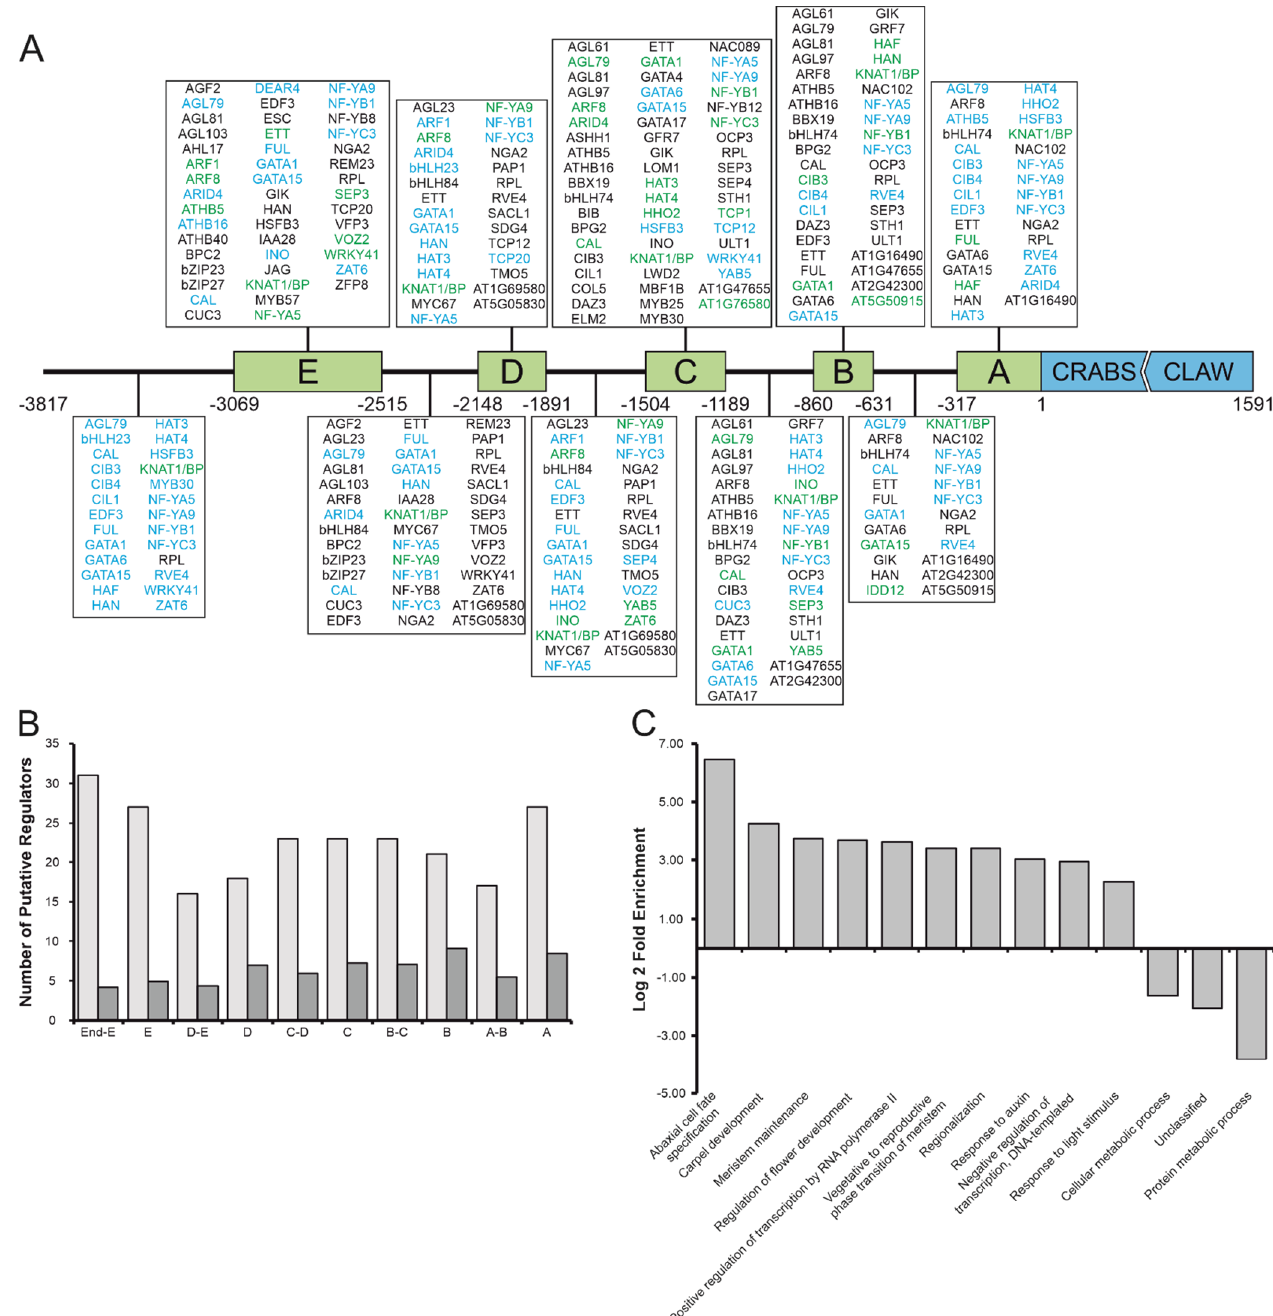
Figure 2. Analysis of transcription factors binding to the CRC promoter identified by Yeast One-Hybrid analysis. ( A ) Spatial distribution of transcription factor binding sites summarizing the Y1H screen of proCRC with transcription factor bait libraries using the fragments indicated in Supplemental Figure S1 as prey. Shown are only transcription factors with a known motif in PlantPan. Binding site proteins in black were identified by Y1H, those in blue by PlantPAN in silico prediction, and those in green indicate positional overlap of Y1H and PlantPAN data. ( B ) Quantitative analysis of putative CRC regulators’ distributions across the different fragments of proCRC . The number of regulators identified by in silico prediction with PlantPAN per 100 bp is shown in light grey, and the number of transcription factor binding sites identified by the Y1H screen per 100 bp are shown in dark grey. ( C ) GO enrichment analysis, categorizing the putative CRC regulators in different functional groups. Shown is the log 2-fold enrichment of significantly overrepresented GO